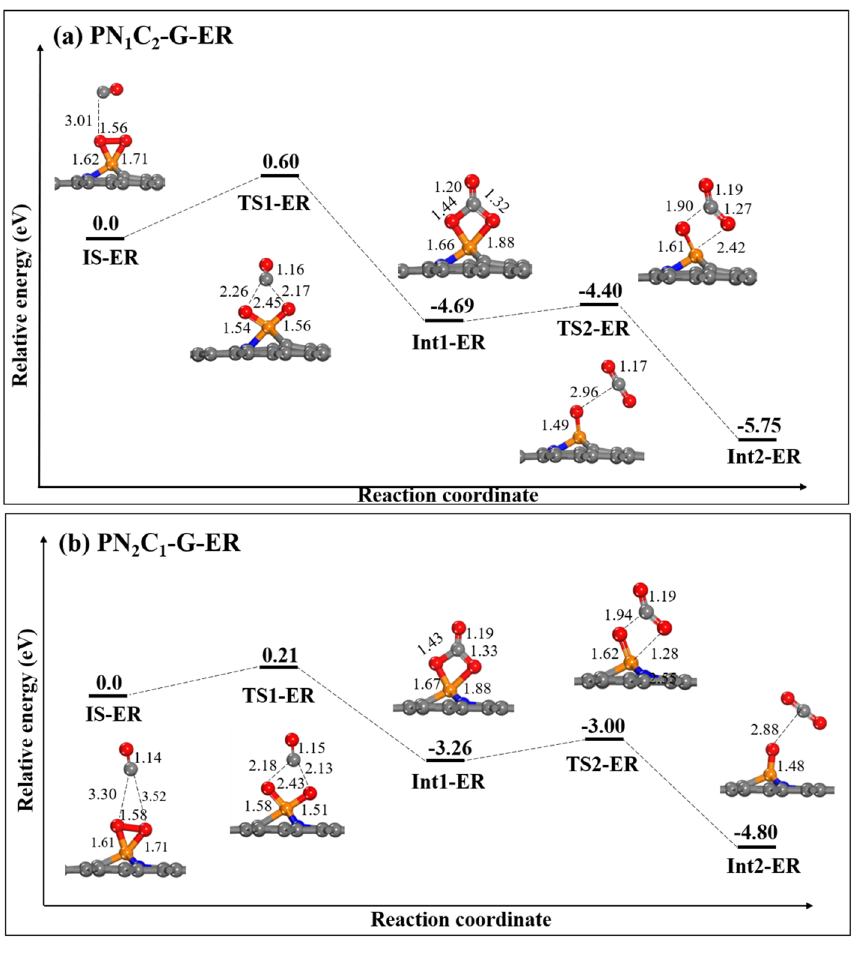
Figure 5. The potential energy surface diagram of CO oxidation via the first step in an ER mechanism ( a ) PN 1 C 2 -G and ( b ) PN 2 C 1 -G . All bond distances are in